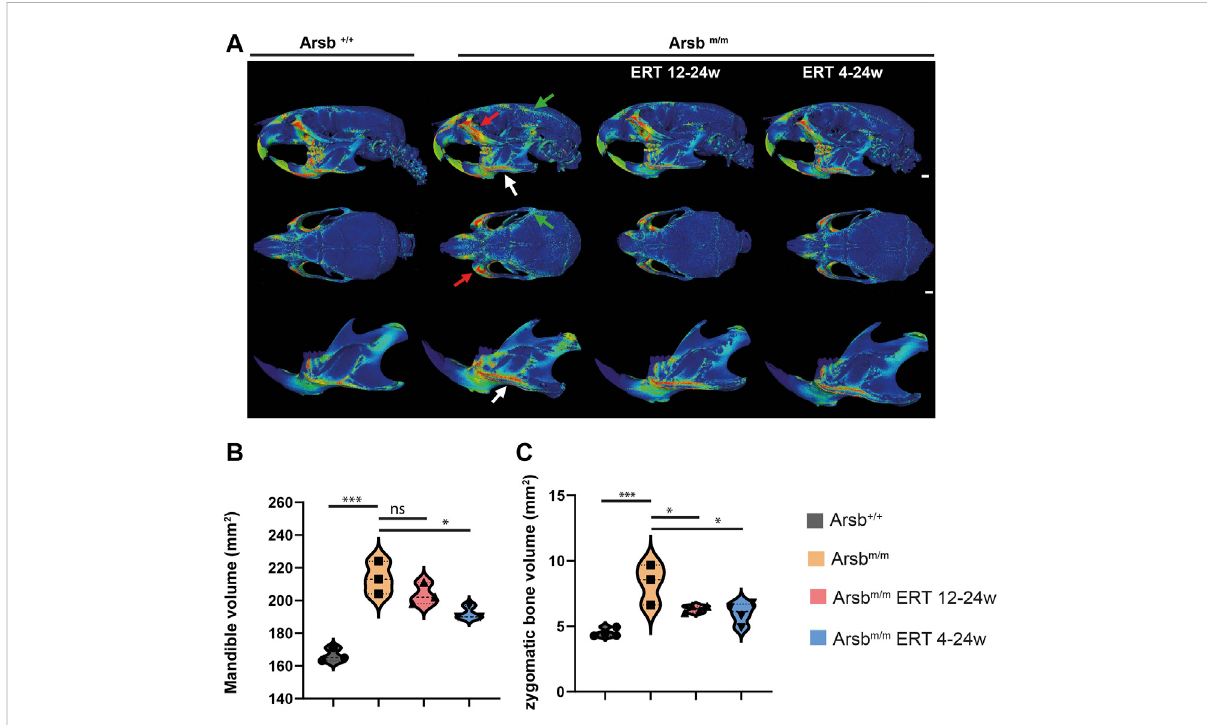
Bone exostoses on the craniofacial skeleton of MPS VI mice. (A) Analysis of wall thickness from micro-CT scans of the skulls of 24-week-old control ( Arsb +/+ ), MPS VI ( Arsb m/m ), and MPS VI mice in which enzyme replacement therapy was initiated after 12 weeks of age ( Arsb m/m ERT 12-24w representing late-start ERT) and after 4 weeks of age ( Arsb m/m ERT 4-24w representing early-start ERT). View from the side (upper panel), overview (middle panel), and separated mandible (lower panel). Arsb m/m mice show bone exostoses at the marked locations: lower margin of the mandibular body (white arrow), zygomatic arch (red arrow), and temporal line (green arrow). These exostoses are less pronounced in Arsb m/m mice with ERT. Scale bar = 1 mm. (B) Quanti fi cation of mandibular bone volume. (C) Quanti fi cation of the zygomatic bone volume. * p < 0.05, ** p < 0.01, *** p <